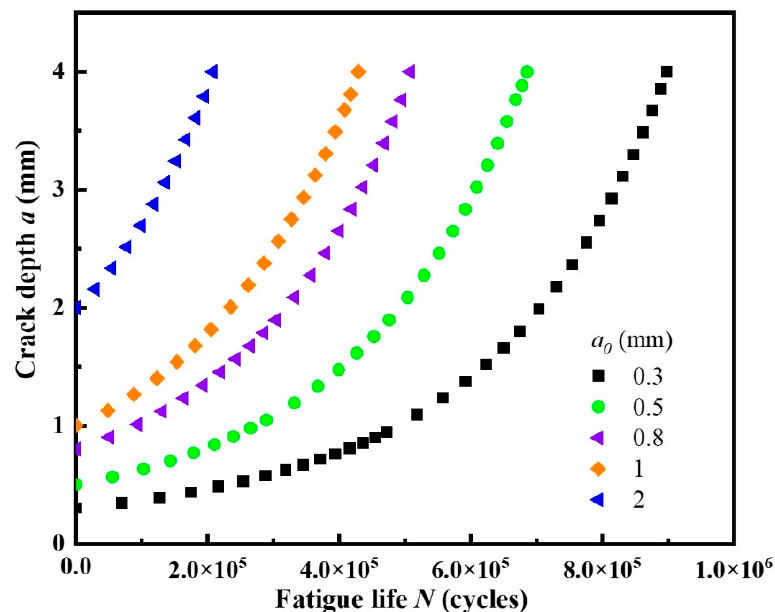
Figure 13. The a - N curve of conical-cylindrical shell. Table 4. Fatigue life of conical-cylindrical shell with different initial